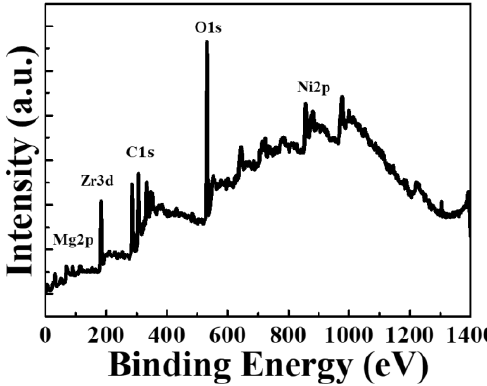
Figure 1. XPS spectra of O 1s, Ni 2p3, Mg 2p, Zr 3d, and C 1s.